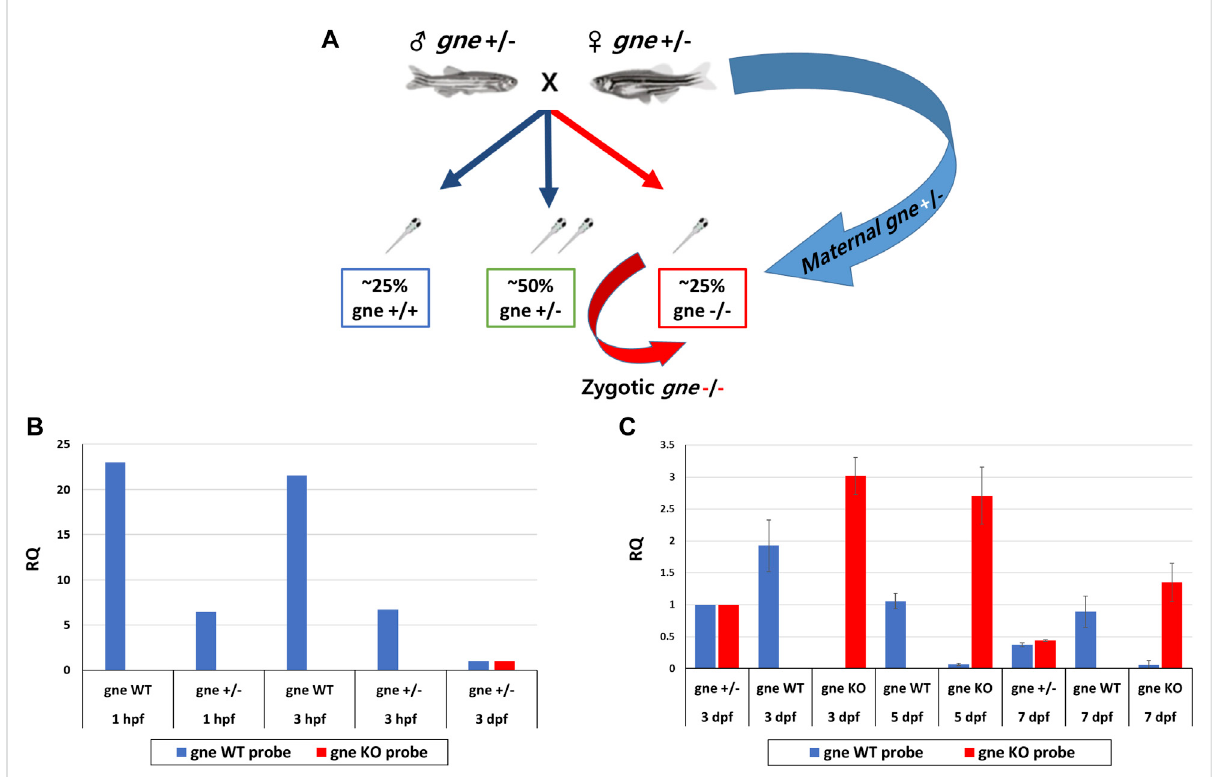
FIGURE 7 Maternal and zygotic expression of gne WT and gne KO alleles. (A) gne maternal inheritance. gne +/- in-cross results in 3 genotypic groups. gne KO embryos are predicted to receive both gne + and gne − maternal transcripts (blue arrow), but the zygotic transcription will only transcribe gne − alleles (redarrow). (B) Maternalexpression of gne WTand gne mutantalleleat1and 3hpfembryos. The relativequanti fi cation(RQ) values of gne WT (blue bars) and gne mutant alleles (red bars) are shown by genotype and age. The WT allele was highly expressed in the WT samples and was lower in gne +/- offspring at 1 and 3 hpf. No ampli fi cation was obtained for thegne KO allele. cDNA sample of gne HT at3 dpf was used as acalibrator for all reactions since it expresses both the WT and the KO alleles. (C) The relative expression of gne WT and gne KO alleles at 3, 5, and 7 dpf. The WT allele was highly expressed in the WT samples but was not found in gne KO at all-time points, and the mutated allele showed the opposite